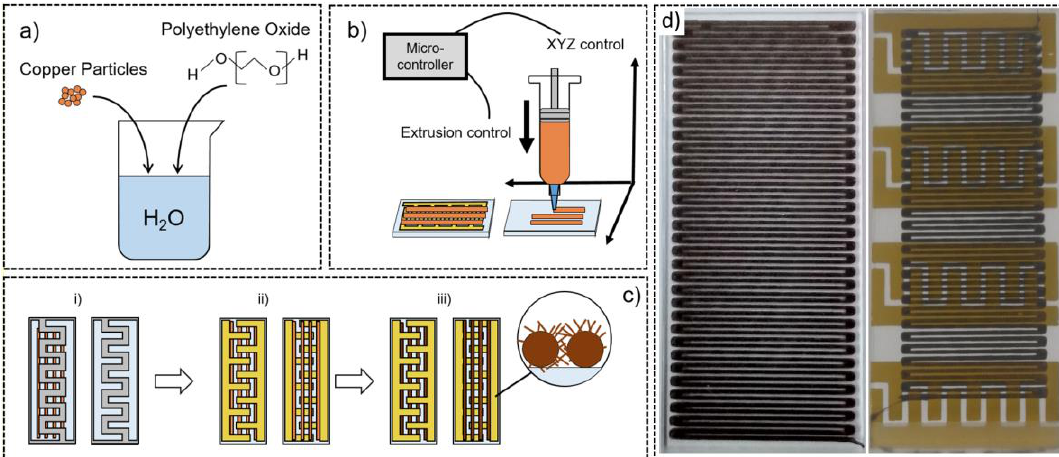
Figure 1. Procedure used for 3D-DIW of the Cu/Cu 2 O/CuO heterojunction-based device: ( a ) ink from copper microparticles and PEO; ( b ) direct ink writing DIW of Cu-ink-based stripes/traces on substrate with and without Au contacts; ( c ) sputtering of Au through a mask ( i , ii ) thermal annealing for Cu/Cu 2 O/CuO heterojunction net growth ( iii ) [23]; ( d ) representative sample after 3D printing and the sample divided into individual sensors by interdigitating the gold contacts. “Reprinted with permission from {Siebert, L.; Lupan, O.; Mirabelli, M.; Ababii, N.; Terasa, M.-I.; Kaps, S.; Cretu, V.; Vahl, A.; Faupel, F.; Adelung, R. 3D-Printed Chemiresistive Sensor Array on Nanowire CuO/Cu 2 O/Cu Heterojunction Nets. ACS Appl. Mater. Interfaces 2019 , 11 , 25508–25515, doi:10.1021/acsami.9b04385}. Copyright {2019} American Chemical